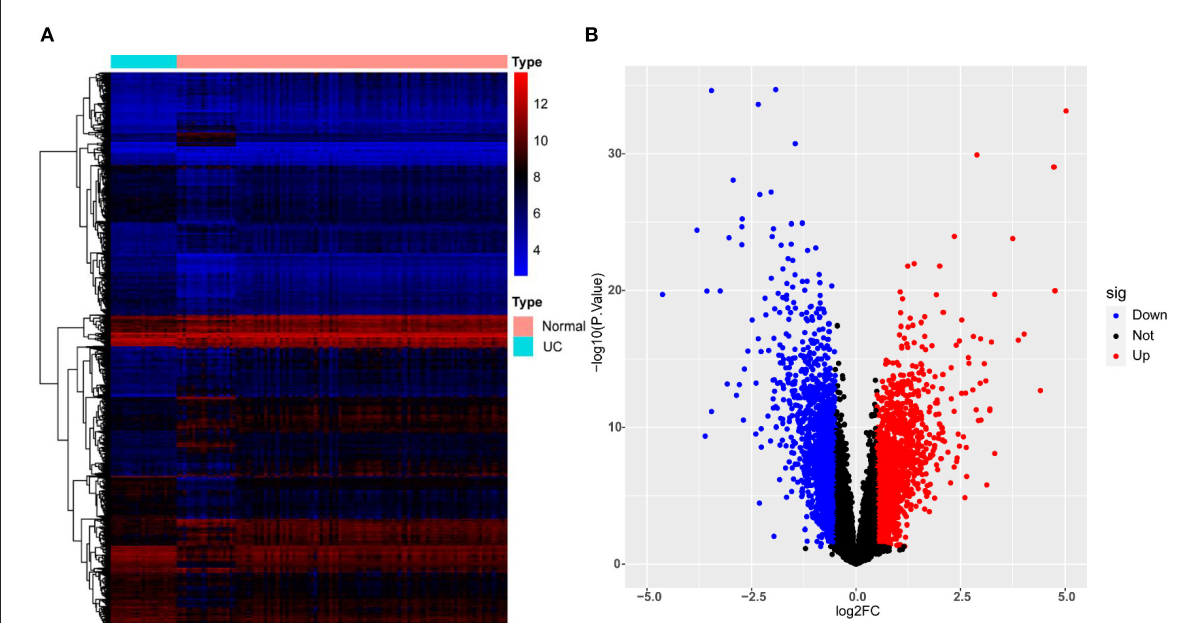
FIGURE2 Heatmap and volcano plot for the DEGs identified from GSE87473. (A) Heat map for DEGs. Each row of the heat map represents one DEG, and each column represents one sample, either healthy or UC; the red and blue colors represent upregulated and downregulated DEGs, respectively. (B) Volcano plot for DEGs. Red plot points represent upregulated DEGs, and blue plot points show downregulated